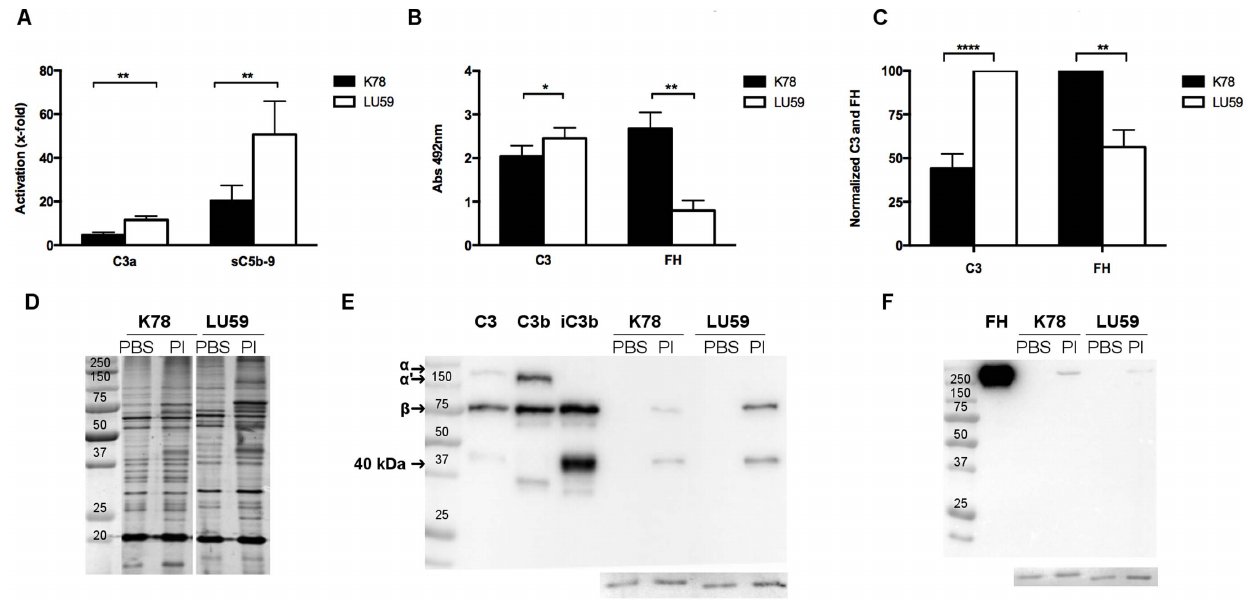
Figure 1. Complement activation and adherence of complement proteins to Borrelia spirochete s incubated in hirudin plasma. A) The ability of the Borrelia strains B. afzelii K78 and B.gariini LU59, resistant and sensitive to complement activation, respectively, to activate complement in hirudin plasma (n=8) was assessed by analyzing the generation of C3a and sC5b-9 using ELISA. Data are normalized against plasma incubated without bacteria and are presented as means 6 SEM. B) Borrelia were incubated with hirudin plasma (n=6), and bound proteins were analyzed using an in-house-developed particle ELISA. Data are shown as absorbance values of bacteria incubated in plasma, normalized against bacteria incubated in PBSCa 2 + , and are presented as means 6 SEM. C) Quantification of bound C3-fragments (using the b -chain that is not proteolytically cleaved) and FH. Results are presented normalized to either K78 or LU59 as mean of six Western blots. D) Silver stained SDS–PAGE of B. afzelii K78 and B.gariini LU59 non-opsonized (PBS) or opsonised (Pl). In addition, C3 and its fragments (E) and FH (F) bound to bacteria incubated with plasma (Pl) were visualized using Western blot with bacteria incubated in PBSCa 2 + as controls, and purified C3, C3b and iC3b or FH as references. Insert: loading control, consisting of a 20kDa Borrelia protein that was detected on the membranes after detection with antibodies.